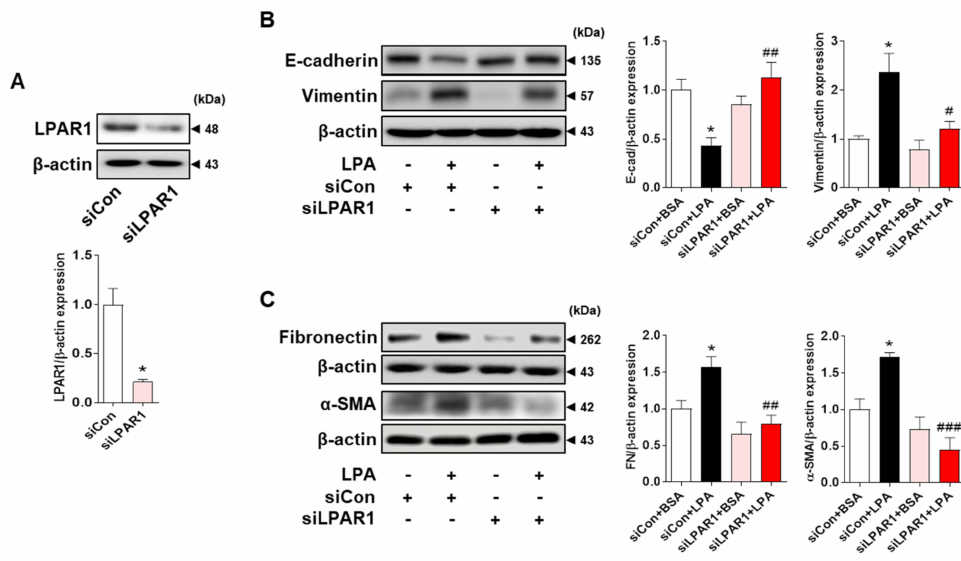
Figure 3. LPAR1 knockdown inhibited LPA − induced changes in the expression levels of EMT markers and fibrotic factors in HK-2 cells. HK-2 cells were transfected with control siRNA (siCon) or LPAR1 siRNA (siLPAR1) for 6 h. Next, the medium was replaced with a serum-free medium (SFM), then the cells were incubated for 16–18 h and treated with 20 µ M LPA for 48 h. Protein levels of ( A ) LPAR1, ( B ) E-cadherin and vimentin, and ( C ) fibronectin and α -SMA were analyzed via Western blotting, quantified using ImageJ software, and normalized to that of β -actin. Representative images (left) and quantitative analysis bar graphs (right) are shown ( n = 3 independent experiments). Data are presented as the mean ± SEM. * p < 0.05 vs. siCon or siCon + BSA; # p < 0.05, ## p < 0.01, ### p < 0.005 vs. siCon +